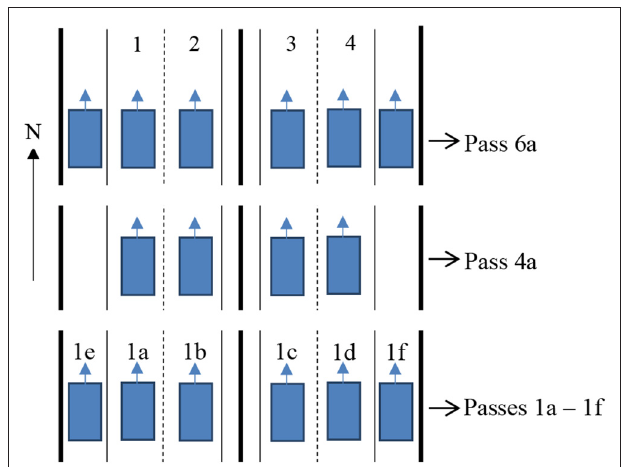
FIGURE 3 | Truck configurations for baseline load